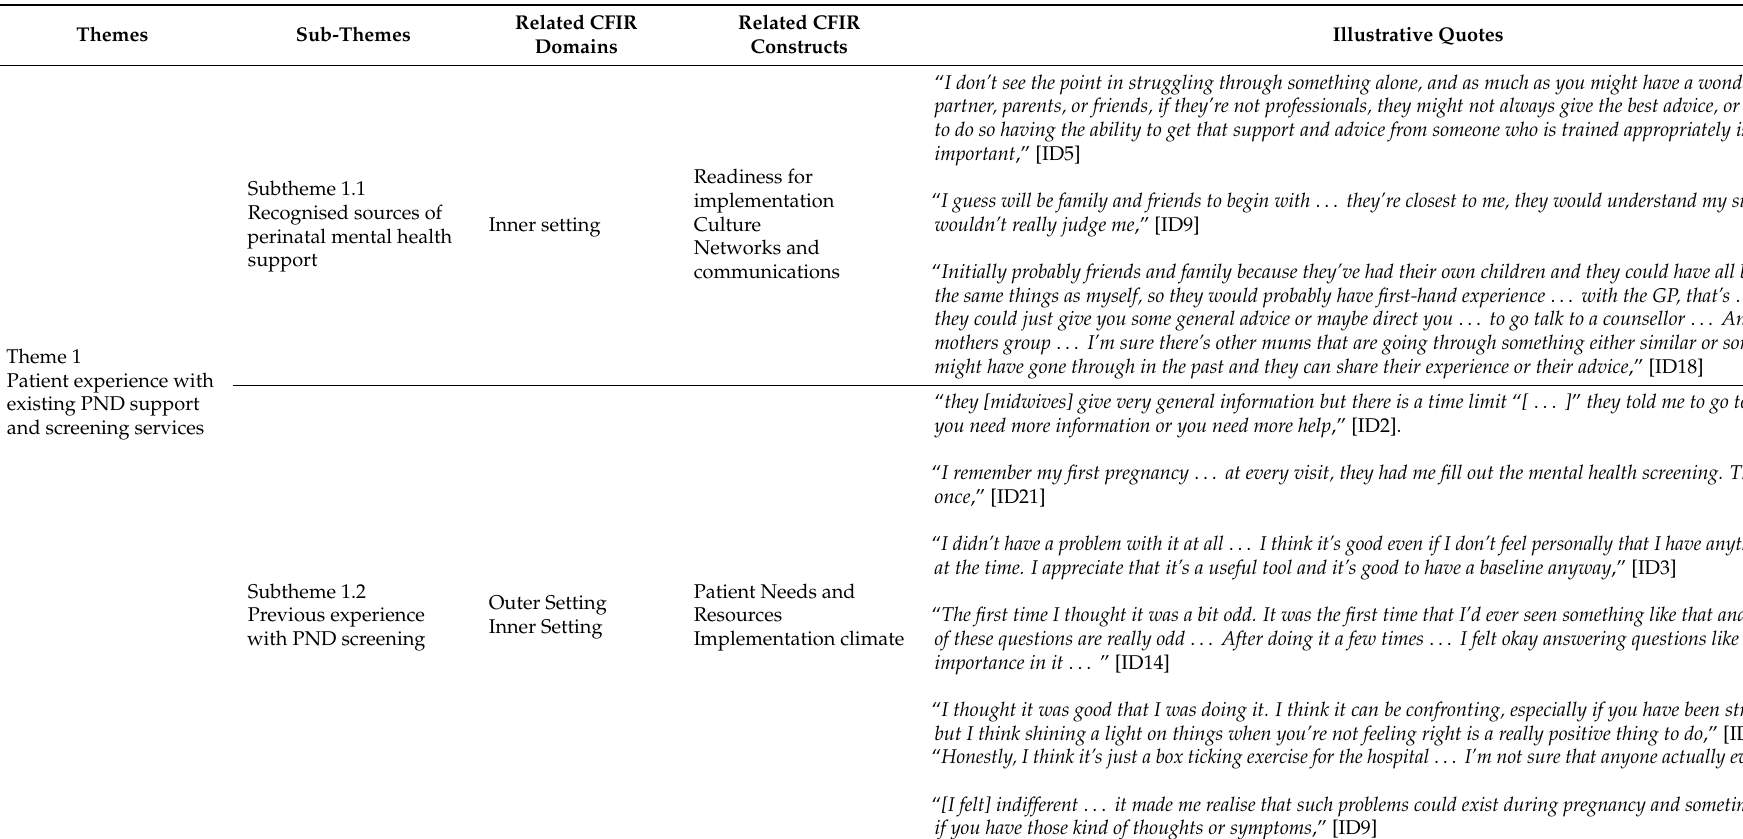
Table A2. Summary themes to pharmacist-delivered PND screening related to CFIR